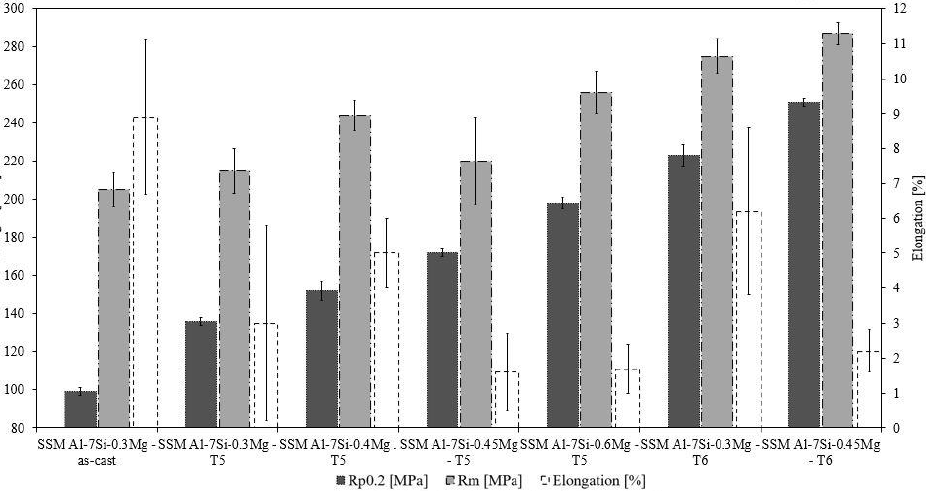
Figure 5. Tensile testing results of the SSM Al – 7Si – Mg castings in the different conditions. Error bars show the standard deviation of the measurements.